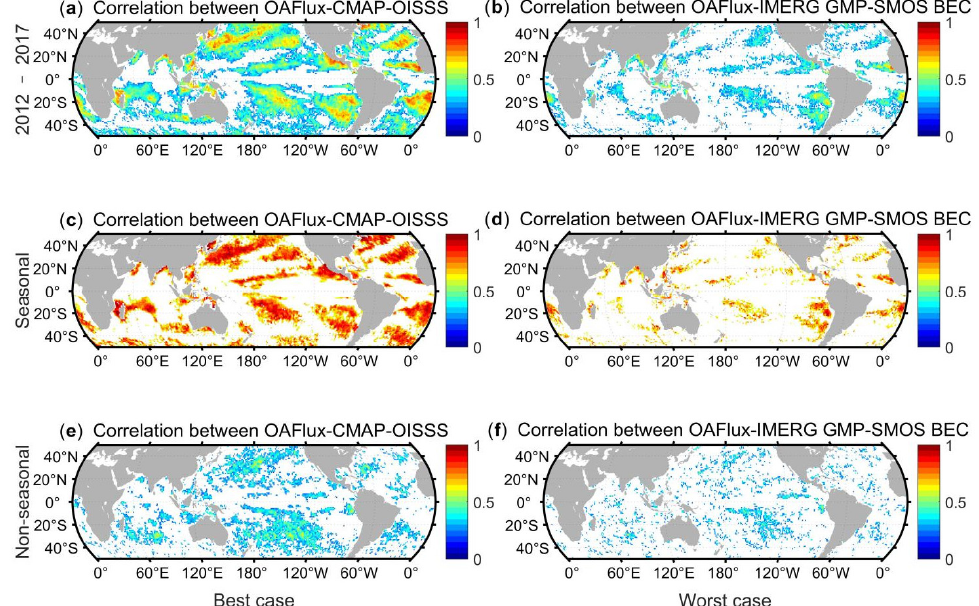
Figure 9. The correlation coefficients between ( a ) FWF and ( b ) SSS tendency in the highest correlation cases “OAFlux-CMAP-OISSS” and the lowest cases “OAFlux-IMERG GPM-SMOS”. The correlation coefficients are calculated from monthly values from 2012 to 2017. Correlation coefficients are between the same two variables based on the ( c , d ) seasonal and ( e , f ) nonseasonal anomalies in two cases. The margin regions denote that FWF and SSS tendency is either insignificant ( p -values > 0.05) or negatively correlated. Figure 10 compares the RMSD between SSS tendency and FWF among 140 sets of products. Similar to the results based on STDs (Figure 5) and correlation (Figure 7), spread in SSS products (STD of RMSD is 0.15 g/kg/year averaged over 28 EMP combinations) makes the largest contribution to the spread in RMSD between SSS tendency and FWF among 140 sets. The spread in RMSD among 𝑃 products is also large, with a magnitude of 0.09 g/kg/year averaged over 20 combinations between the 𝐸 and SSS products. For example, in Figure 10a, a set of SMOS BEC-OAFlux-CMAP is 1.42 g/kg/year, and a set of SMOS BEC-OAFlux-GMP IMERG is 1.72 g/kg/year. The difference between them is 0.3 g/kg/year due to the different P products used. The spread in 𝐸 contributes the least to the spread in RMSD between SSS tendency and FWF among 140 sets of combinations, which indicates a strong consistency among 𝐸 products. The minimum RMSD between FWF and SSS tendency occurs in sets of OAFlux-CMAP-OISSS, with values of 1.314 g/kg/year. The maximum RMSD between FWF and SSS tendency appears in sets of JOFURO-GPM IMERG-SMOS CEC, with values of 1.97 g/kg/year. The mean RMSD averaged among 140 sets of combinations is 1.59 g/kg/year and the spread in RMSD is 0.16 g/kg/year. This result suggests that a 10% difference in RMSD between the SSS tendency and FWF is caused by the different combinations of sets of “ 𝐸 - 𝑃 -SSS” products.